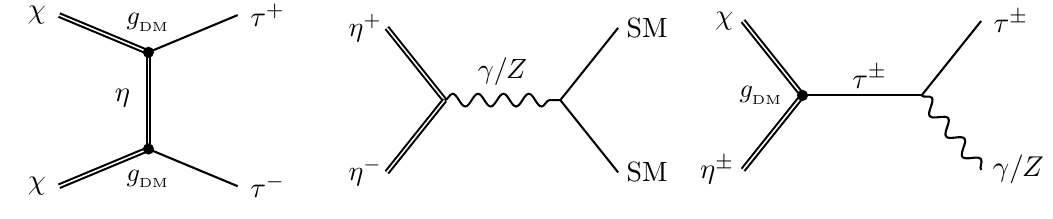
Figure 1 . Annihilation and co-annihilation